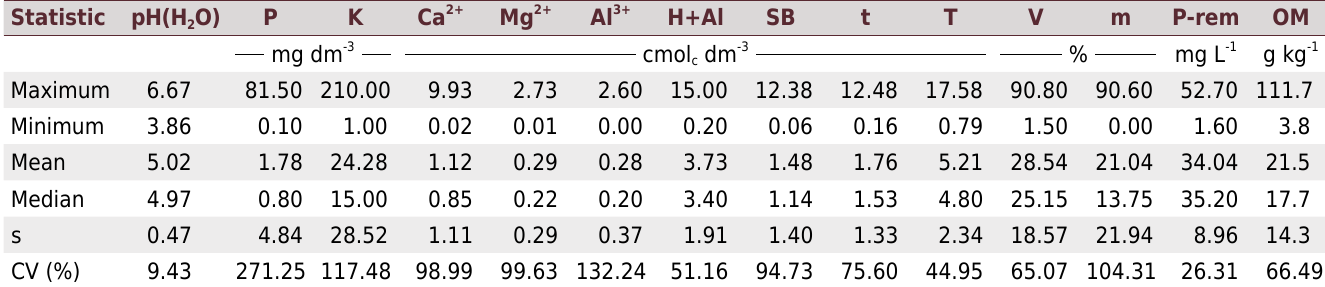
Table 2. Maximum and minimum values, mean, median, standard deviation (s), and coefficient of variation (CV) of chemical properties determined in 600 soil samples considering coffee cultivation